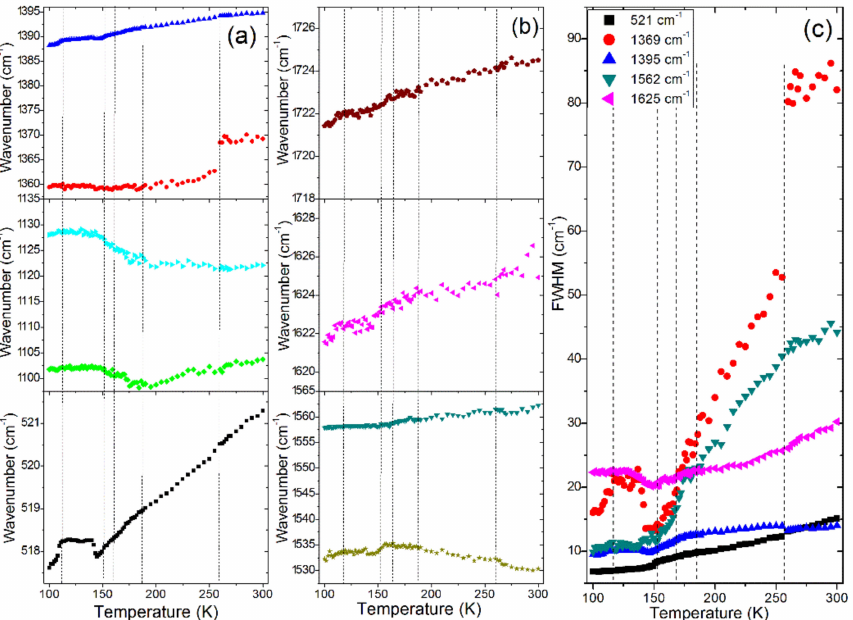
Figure 7. Plots of Raman ( a , b ) wavenumbers and ( c ) FWHM for internal modes of a FAPbBr 3 single